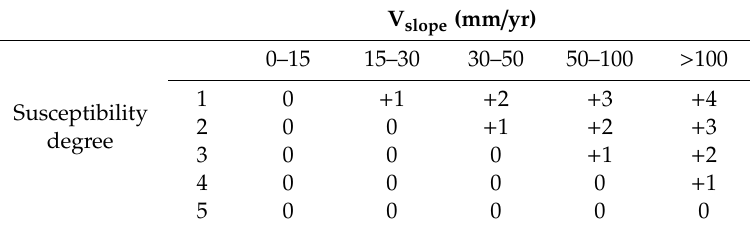
Table 2. Contingency matrix applied to the LSM, considering the average value of V slope in each cell (the susceptibility degree from 1 to 5 represents very low, low, moderate, high, and very high, respectively). V slope (mm / yr) 0–15 15–30 Susceptibility degree